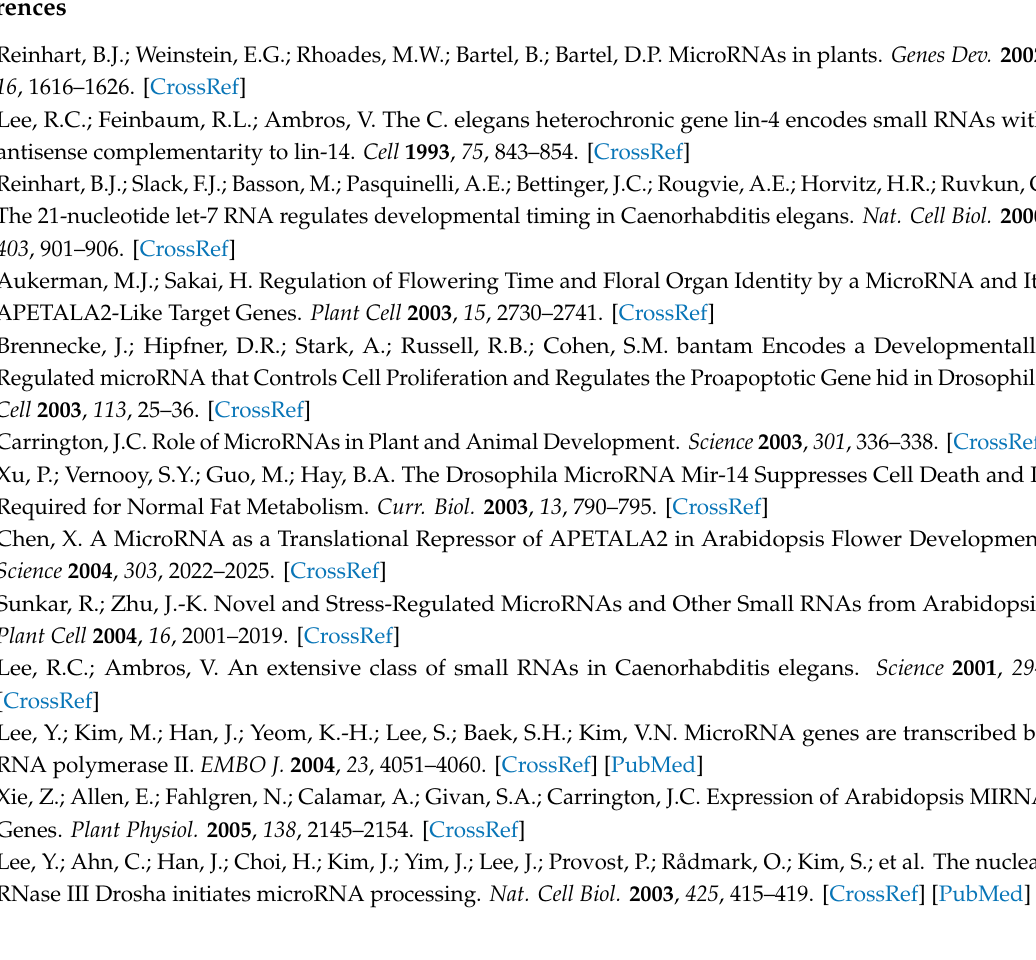
Table S1 Locations of miRNA families and the numbers of pre-miRNA loci on the J. regia (Jr) and J. microcarpa (Jm) chromosomes, Table S2 Comparisons between miRNA prediction in TAIR10 and miRNA annotation in TAIR10, Table S3 Characteristics of mature miRNAs and pre-miRNAs identified in J. regia , Table S4 Characteristics of mature miRNAs and pre-miRNAs identified in J. microcarpa , Table S5 Chromosome locations of target genes and miRNAs in the J. regia genome and their regulation by miRNAs, Table S6 Chromosome locations of target genes and miRNAs in the J. microcarpa genome and their regulation by miRNAs, Table S7 Functional classification for targets genes in the J. regia and J. microcarpa genomes, Table S8 List of KEGG for the miRNA targets identified in J. regia , Table S9 List of KEGG for the miRNA targets identified in J. microcarpa